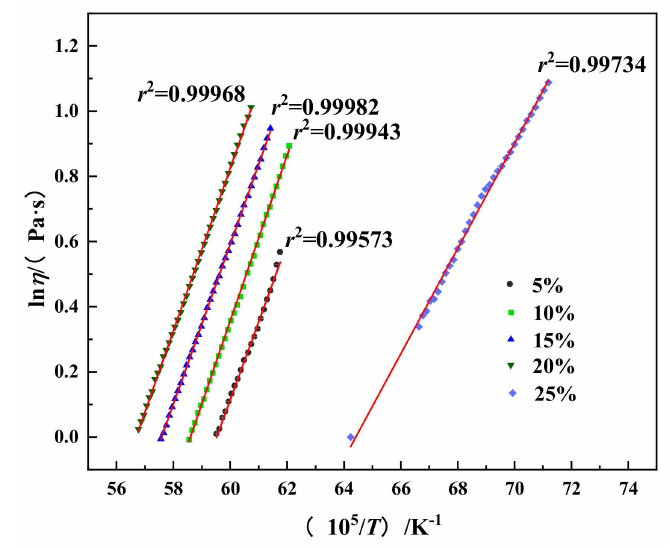
Figure 5. Fitting curve of ln η and 1